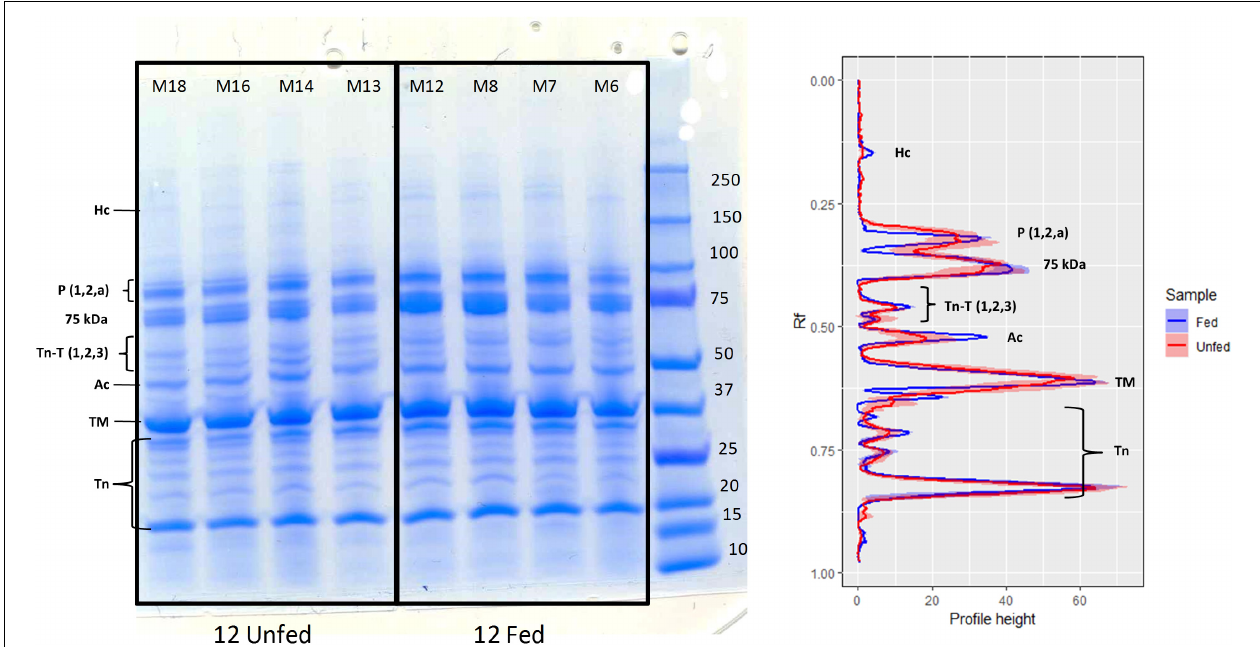
FIGURE 4 | 1D-SDS-PAGE of muscle proteins extracted from H. gammarus fed and unfed kept at 12 ◦ C ( n = 4/group). Band intensity measured as profile height to relative mobility ( R f ) from 1D-SDS-PAGE gels. Lines represent the mean and colored areas represent S.E.M (fed shown in blue and fasted in red; n = 4). Ac, actin; Hc, myosin heavy chain; TM, tropomyosin; Tn, troponin (include troponin C and troponin I isoforms); TnT, troponin (three isoforms); P, paramyosin; 75 kDa unnamed fast muscle protein (Stentiford et al.,